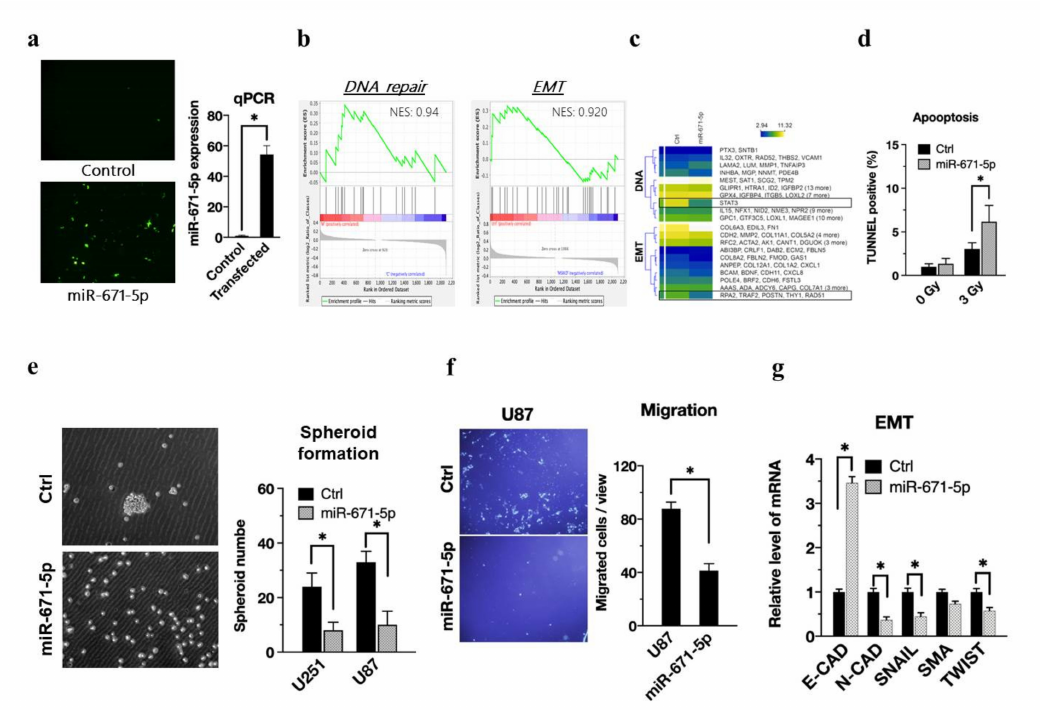
Figure 2. miR-671-5p associates with reducing radioresistance, cancer stem-like cell property and epithelial-mesenchymal transition. ( a , left) Representative image of miR-671-5p-transfected cells with emGFP labeling. The emGFP-positive cells were compared to the control group and presented as a mean from three independent experiments with SD error bars. ( a , right) qRT-PCR analysis of miR-671- 5p expression in GBM U87MG cells compared to control group. ( b ) Gene Set Enrichment Analysis of all affected genes by miR-671-5p overexpression (fold change >2 and <0.5). NES, normalized Enrichment Score. ( c ) The heatmap of individual genes including DNA repair and EMT associated genes from the GSEA analysis. Yellow: the upregulated genes; blue: the downregulated genes. ( d )TUNEL assay profiling apoptosis status of control(ctrl), and miR-671-5p- overexpressed cells after 0 or 3 Gy irradiation. TUNEL positive cells were compared to the control group and presented as a mean from three independent experiments with SD error bars. ( e ) The spheroid formation assay of MSI1-overexpressed GBM U87MG cells. The spheroid number were compared to the control group and presented as a mean from three independent experiments with SD error bars. ( f ) Migration assay profiling migration ability of miR-671-5p-overexpressed cells. The migrated cell number was quantified into a box plot. ( g ) qRT-PCR analysis of expression of EMT associated genes in U87MG cells. GAPDH was used as a loading control. The mRNA level is compared to the control group, quantified relative to the vehicle group, and presented as a mean from three independent experiments with SD error bars. Asterisk indicates a statistically significant difference (Student’s t -test, * p <